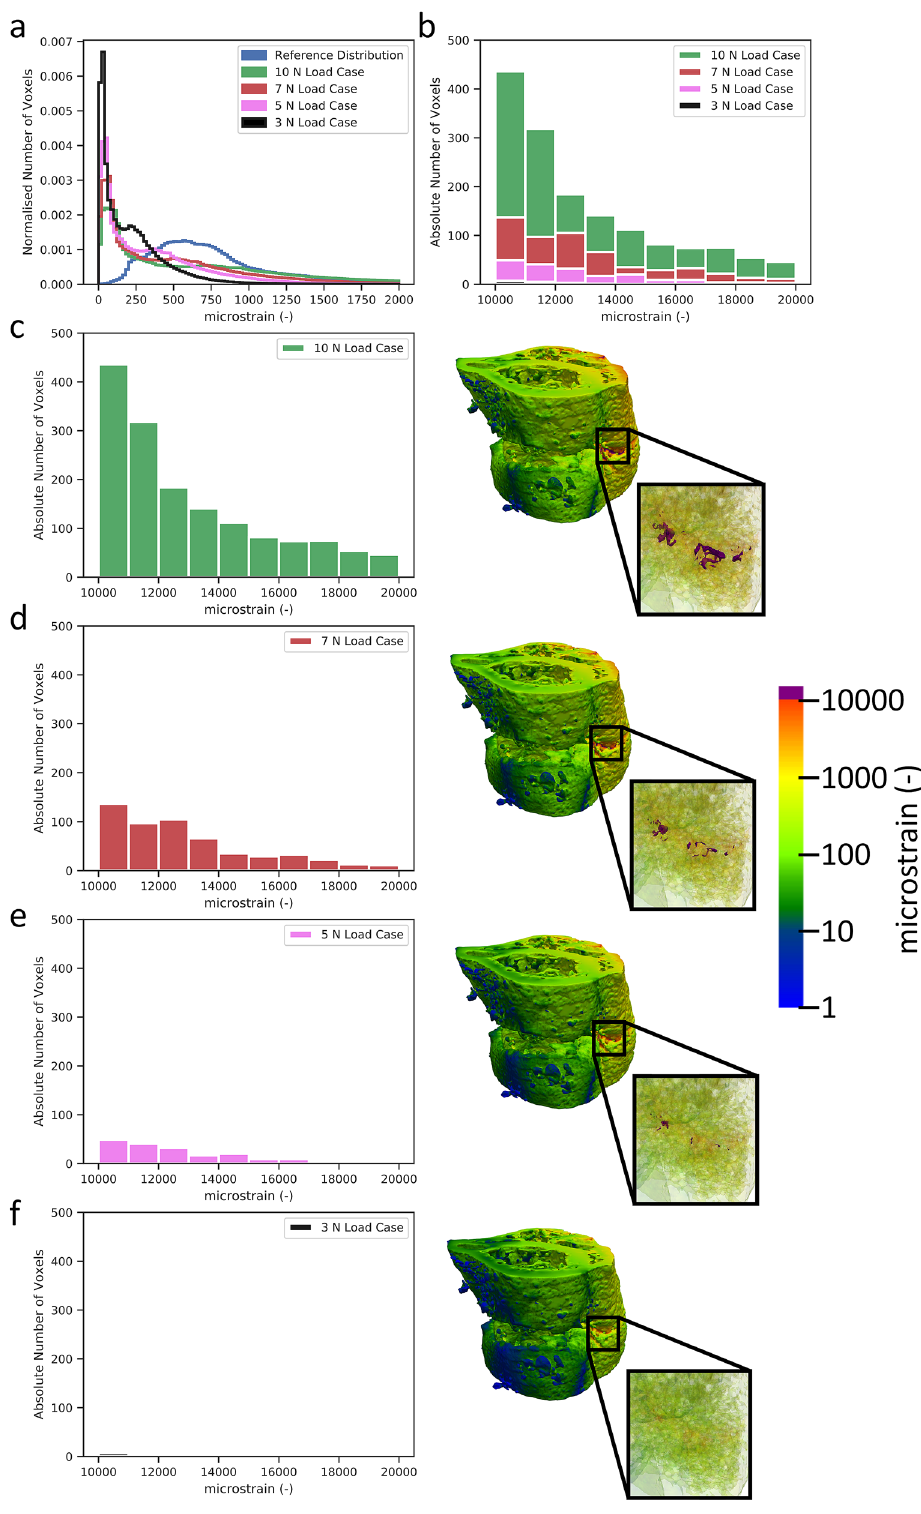
Figure 5. Fracture risk profiling ( a ) identifies the number of voxels over 1% strain ( b ) and down scales the load ( c – f ) until there are less than 50 voxels in the identified strain risk